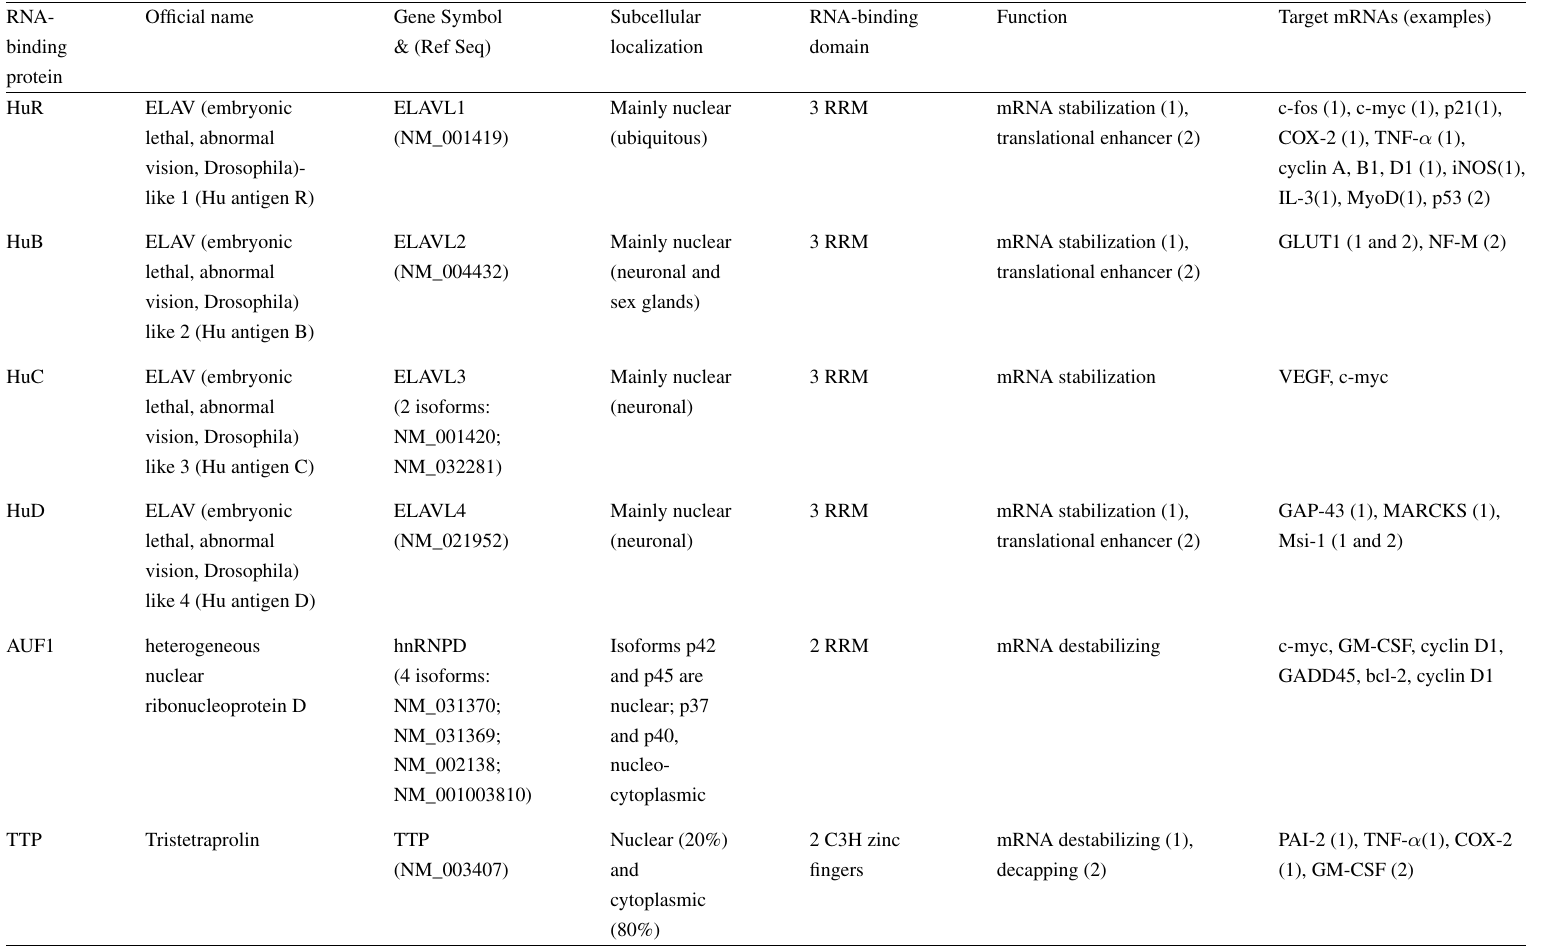
List of AU-rich binding proteins